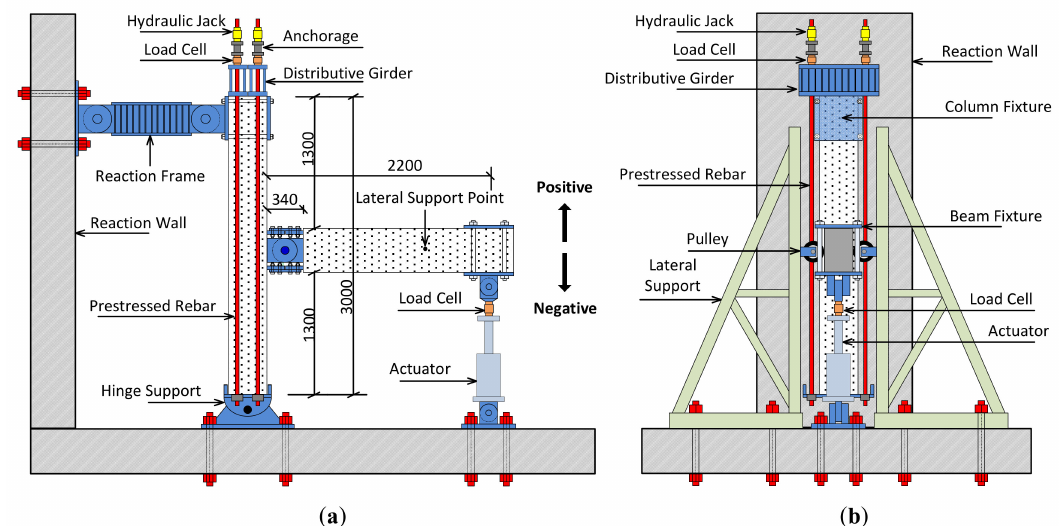
Figure 6. Schematic view: ( a ) Front view; ( b ) Side view. The actuator was vertically arranged at the right beam-end, and the bottom and the top column-ends were hinged. Two lateral triangular supports were arranged on both sides of the beam to prevent the precast beam from moving out of the plane during the loading process. Pulleys were arranged on the beam surfaces to limit the out-of-plane horizontal movement of the precast beam, and the beam could move freely in the vertical direction when loaded. Figure 7 shows the loading device of PBSEC joints.